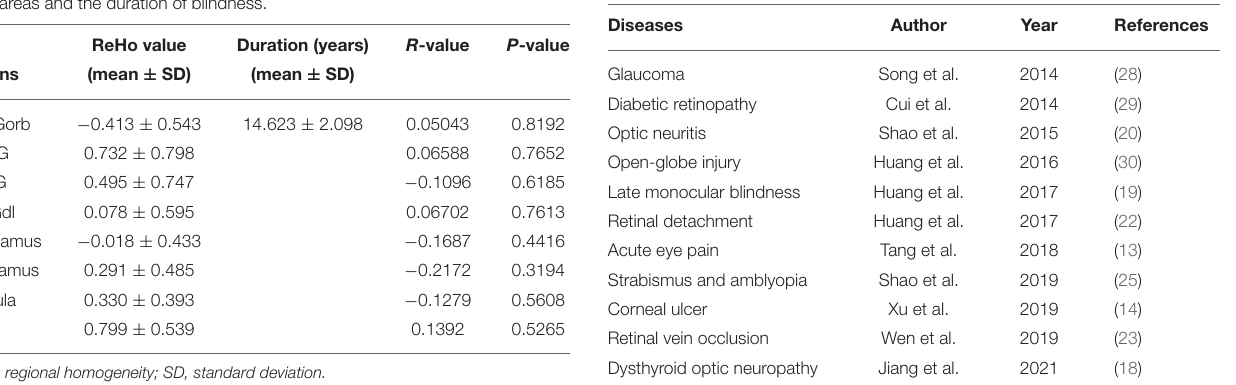
TABLE 5 | Application of ReHo in ophthalmological